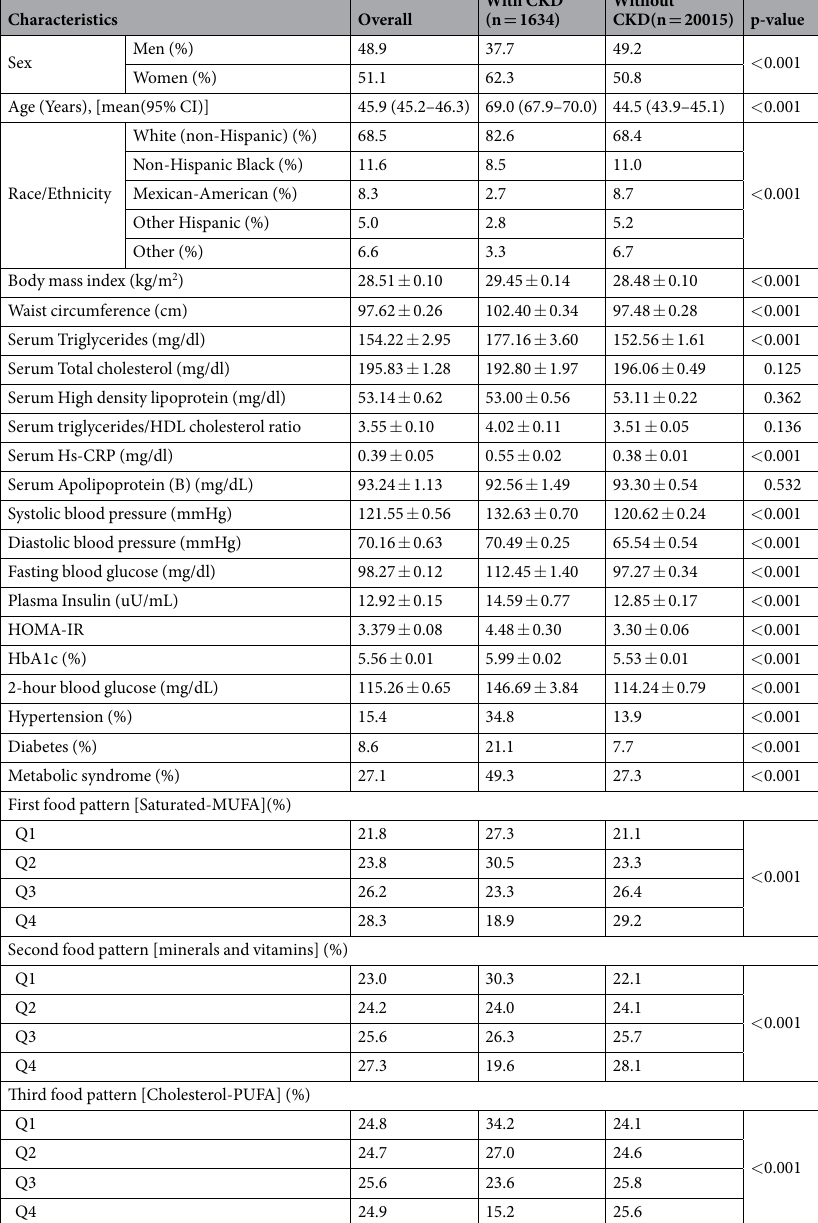
Table 1. Demographic characters of subjects based on chronic kidney diseases status. CKD, chronic kidney diseases; HDL, high density lipoprotein; HOMA-IR, homeostatic model assessment of insulin resistance; hs- CRP, high sensitivity c-reactive protein; MUFA, mono-unsaturated fatty acid; PUFA, polyunsaturated fatty acid; values are expressed as a mean and standard error of the mean; Q1-Q4; quarters. Quarters were derived based on the distribution of each targeted food pattern generating four groups with approximately equal number of